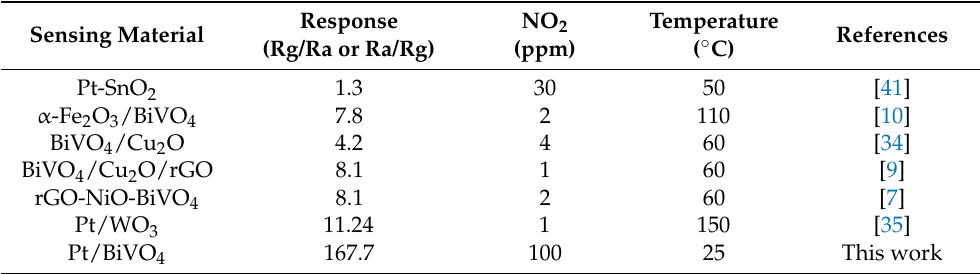
Table 2. Comparison of working temperature and various NO 2 sensors based on Pt or BiVO 4